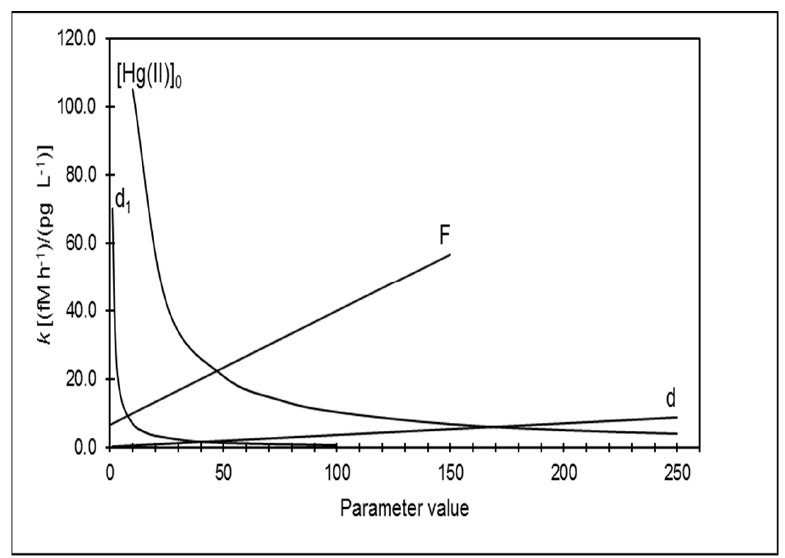
Figure 5. Results of the model sensitivity study for the model parameters of water column depth ( d ), the depth of the surface photic zone ( d 1 ), initial Hg(II) concentration [Hg(II)] 0 , and Hg(0) emiss-ion flux ( F ).